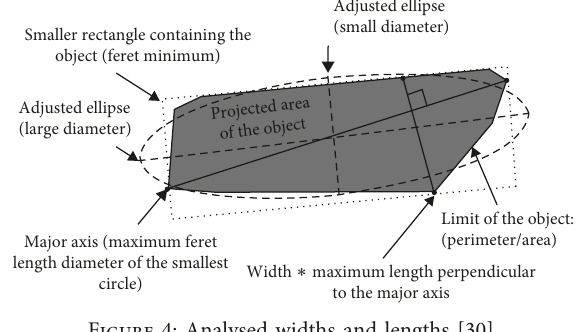
Figure 4: Analysed widths and lengths [30]. Table 3: General presentation of data from image analysis. Particle